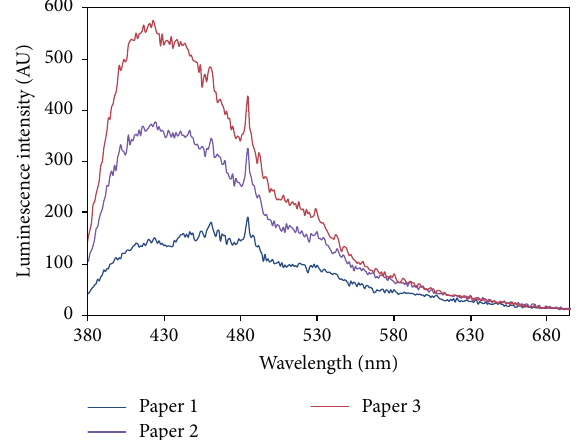
Figure 2: The luminescence spectra of the selected papers with low content of OBA in paper structure: paper 1: the minimum content of OBA; paper 2: the medium content of OBA; paper 3: the maximum content of OBA. 𝜆 exc . = 330